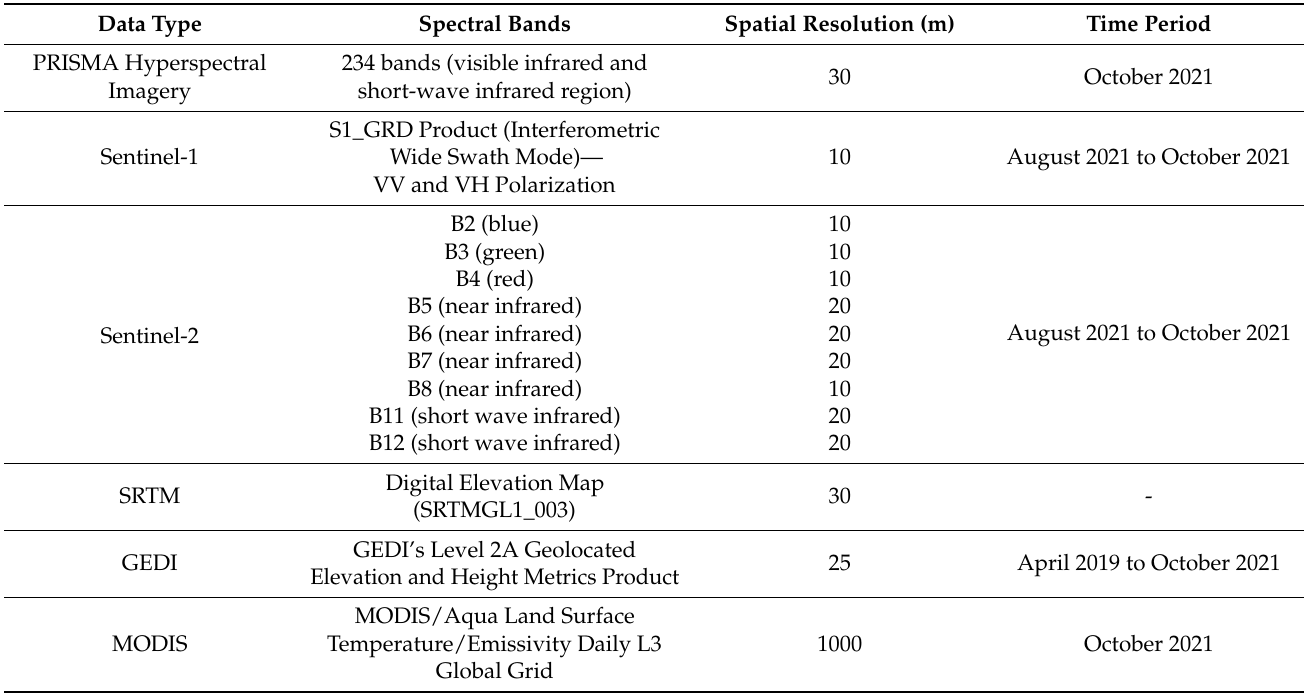
Table 1. Remote-Sensing Datasets Utilized in This Study.